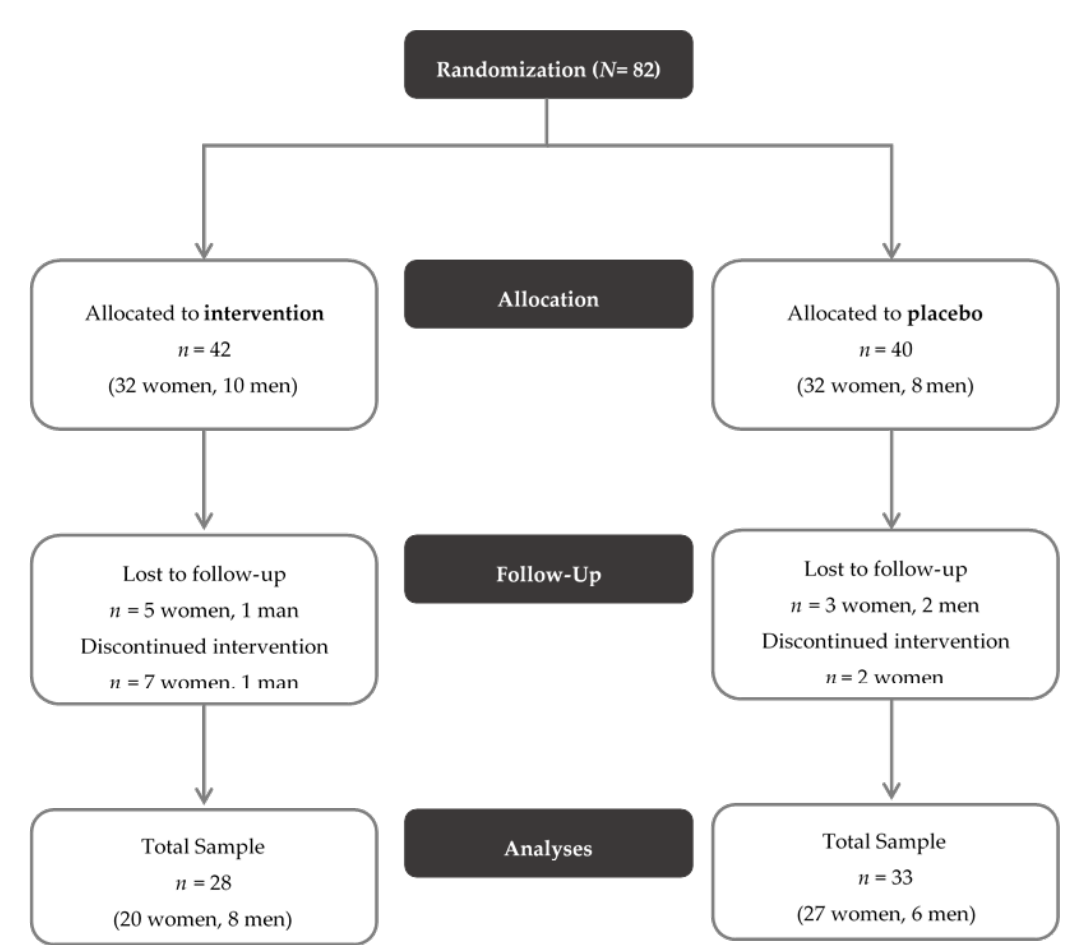
Figure 1. CONSORT Flow Diagram of the PROVIT study. Exclusion criteria consisted of acute suicidality, lack of consent, pregnancy or breastfeeding, severe active drug dependence (i.e., alcohol, benzodiazepines, morphine), other currently active severe cerebral organic diseases (e.g., epilepsy, brain tumor), severe skull- brain trauma / brain surgery in the past, known florid tumor disease, congenital / infantile mental disability, moderate / severe dementia, severe florid autoimmune diseases or current immunosuppression (e.g., lupus erythematosus, HIV, multiple sclerosis), antibiotic therapy within the last month, chronic laxative abuse, acute infectious diarrheal disease, regular intake of butyrate-containing or probiotic supplements in the last year, intake of (other) probiotics and prebiotics or butyrate preparations during the entire trial or within the last month and intake of antibiotics or prebiotics during the entire trial or within the last